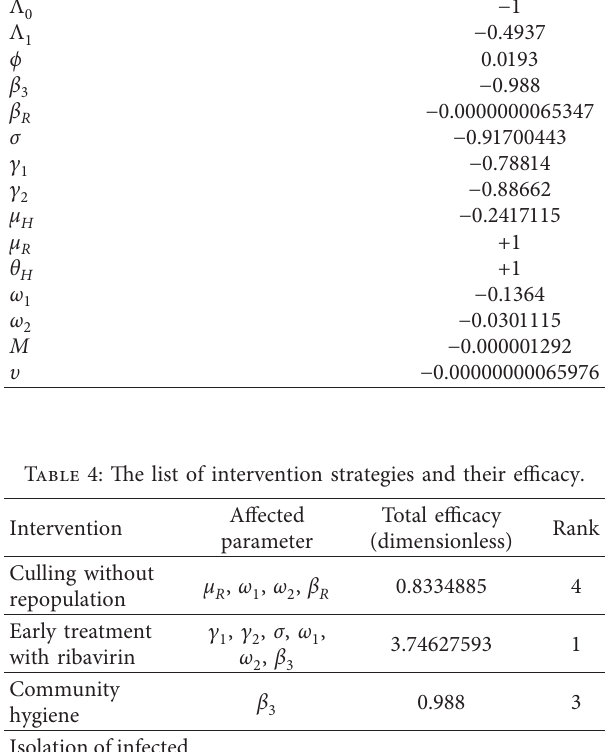
Table 3: Elasticities of I ∗